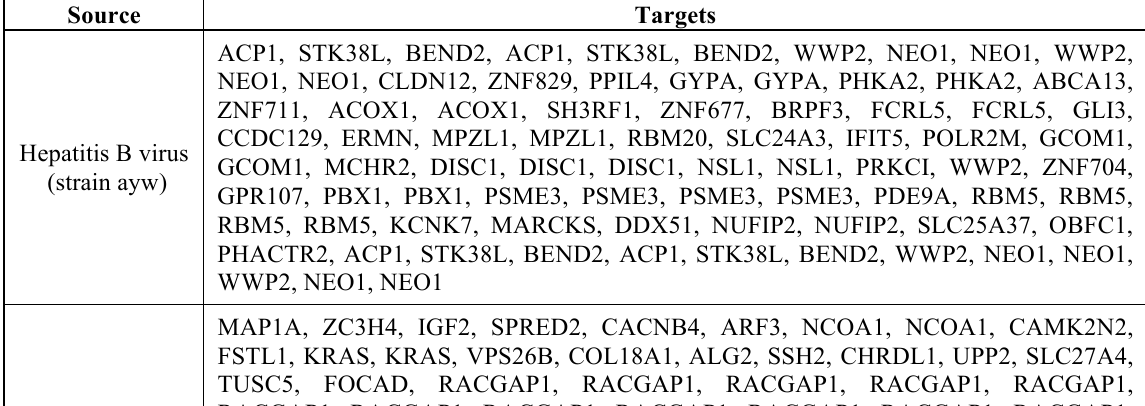
Table 3: Targets of predicted viral miRNAs in the human genome.